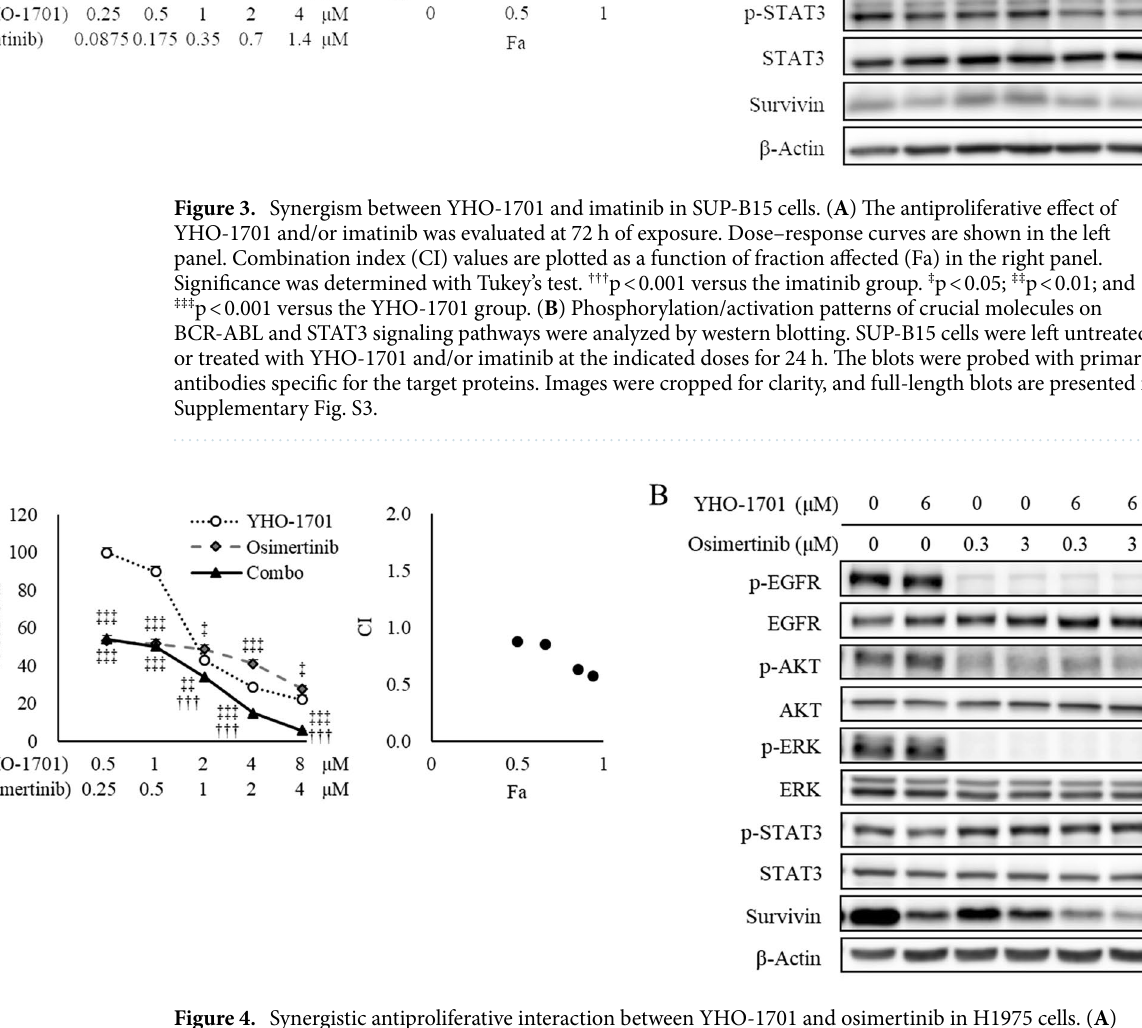
Figure 4. Synergistic antiproliferative interaction between YHO-1701 and osimertinib in H1975 cells. ( A ) The antiproliferative effect of YHO-1701 and/or osimertinib was examined at 72 h of exposure. Dose–response curves of YHO-1701 and/or osimertinib in H1975 cells (left panel) and their CI versus fraction affected (Fa) plots (right panel) are shown. Significance was determined with Tukey’s test. ††† p < 0.001 versus the osimertinib group. ‡ p < 0.05; ‡‡ p < 0.01; and ‡‡‡ p < 0.001 versus the YHO-1701 group. ( B ) Phosphorylation/activation patterns of relevant molecules on EGFR and STAT3 signaling pathways were assessed by western blotting. H1975 cells were left untreated or treated with YHO-1701 and/or osimertinib at the indicated doses for 24 h. The blots were probed with the respective primary antibodies. Images were cropped for clarity, and full-length blots are displayed in Supplementary Fig.